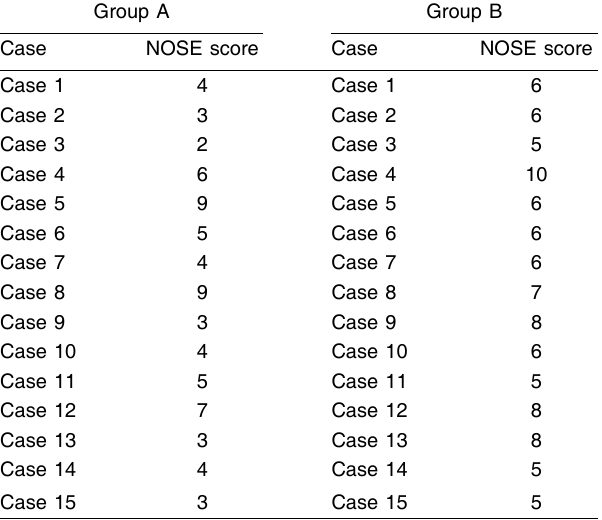
Table 2 Postoperative NOSE score in groups A and B